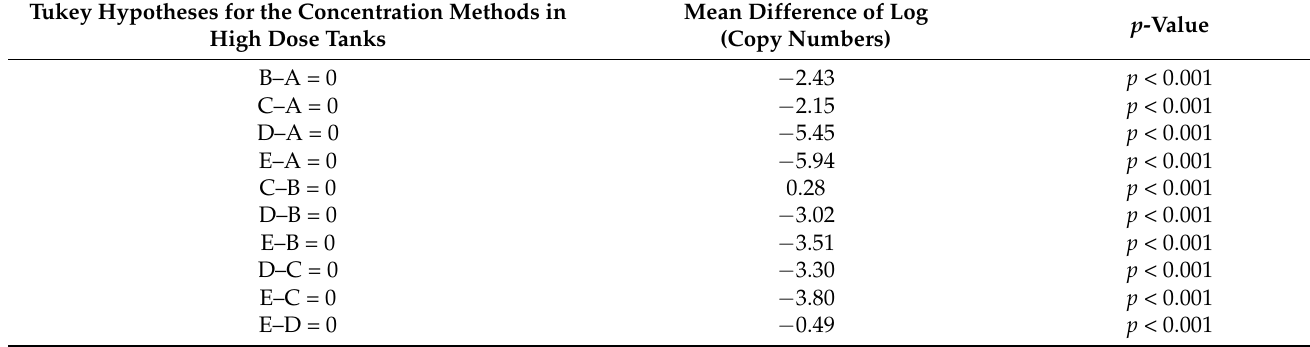
Table 1. Post hoc Tukey HSD pairwise comparisons of five concentration methods (A–E), the two membrane filters (MF - or MD + ) and the four buffer solutions (buffer 1–4). The columns indicate the null hypothesis, the mean difference, and the p -values. Negative mean differences in estimates in the first five rows indicate that method A recovered more copies of the ISAV genome than any of the other methods. All estimates are